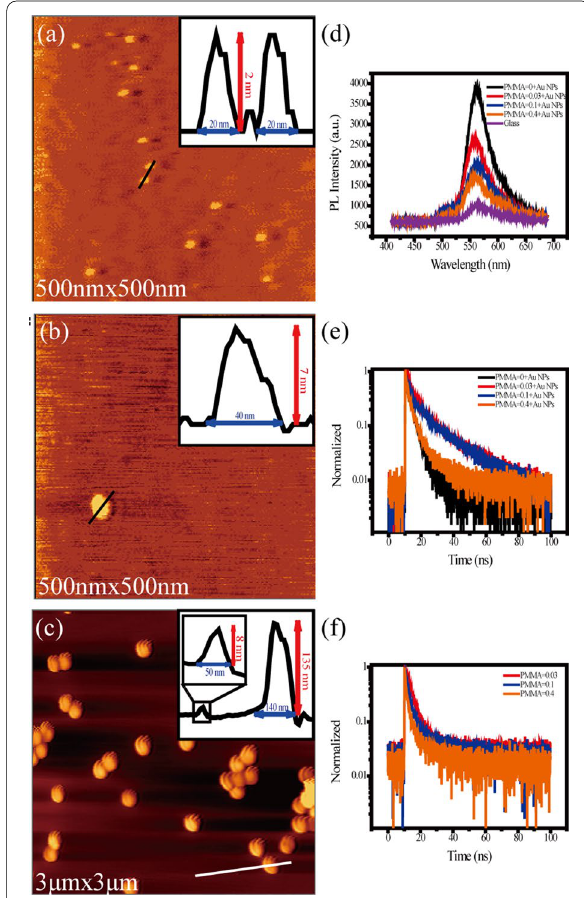
Fig. 4 Typical AFM image of R6G molecules on glass ( a ), PMMA/ glass ( b ), PMMA/Au NPs/glass ( c ). Insets: line profiles of R6G molecular clusters. d , e Fluorescence spectra and dynamics of PL decay of R6G/ glass, R6G/Au NPs/glass and R6G/PMMA/Au NPs/glass, respectively. f Dynamics of PL decay of R6G/PMMA/glass